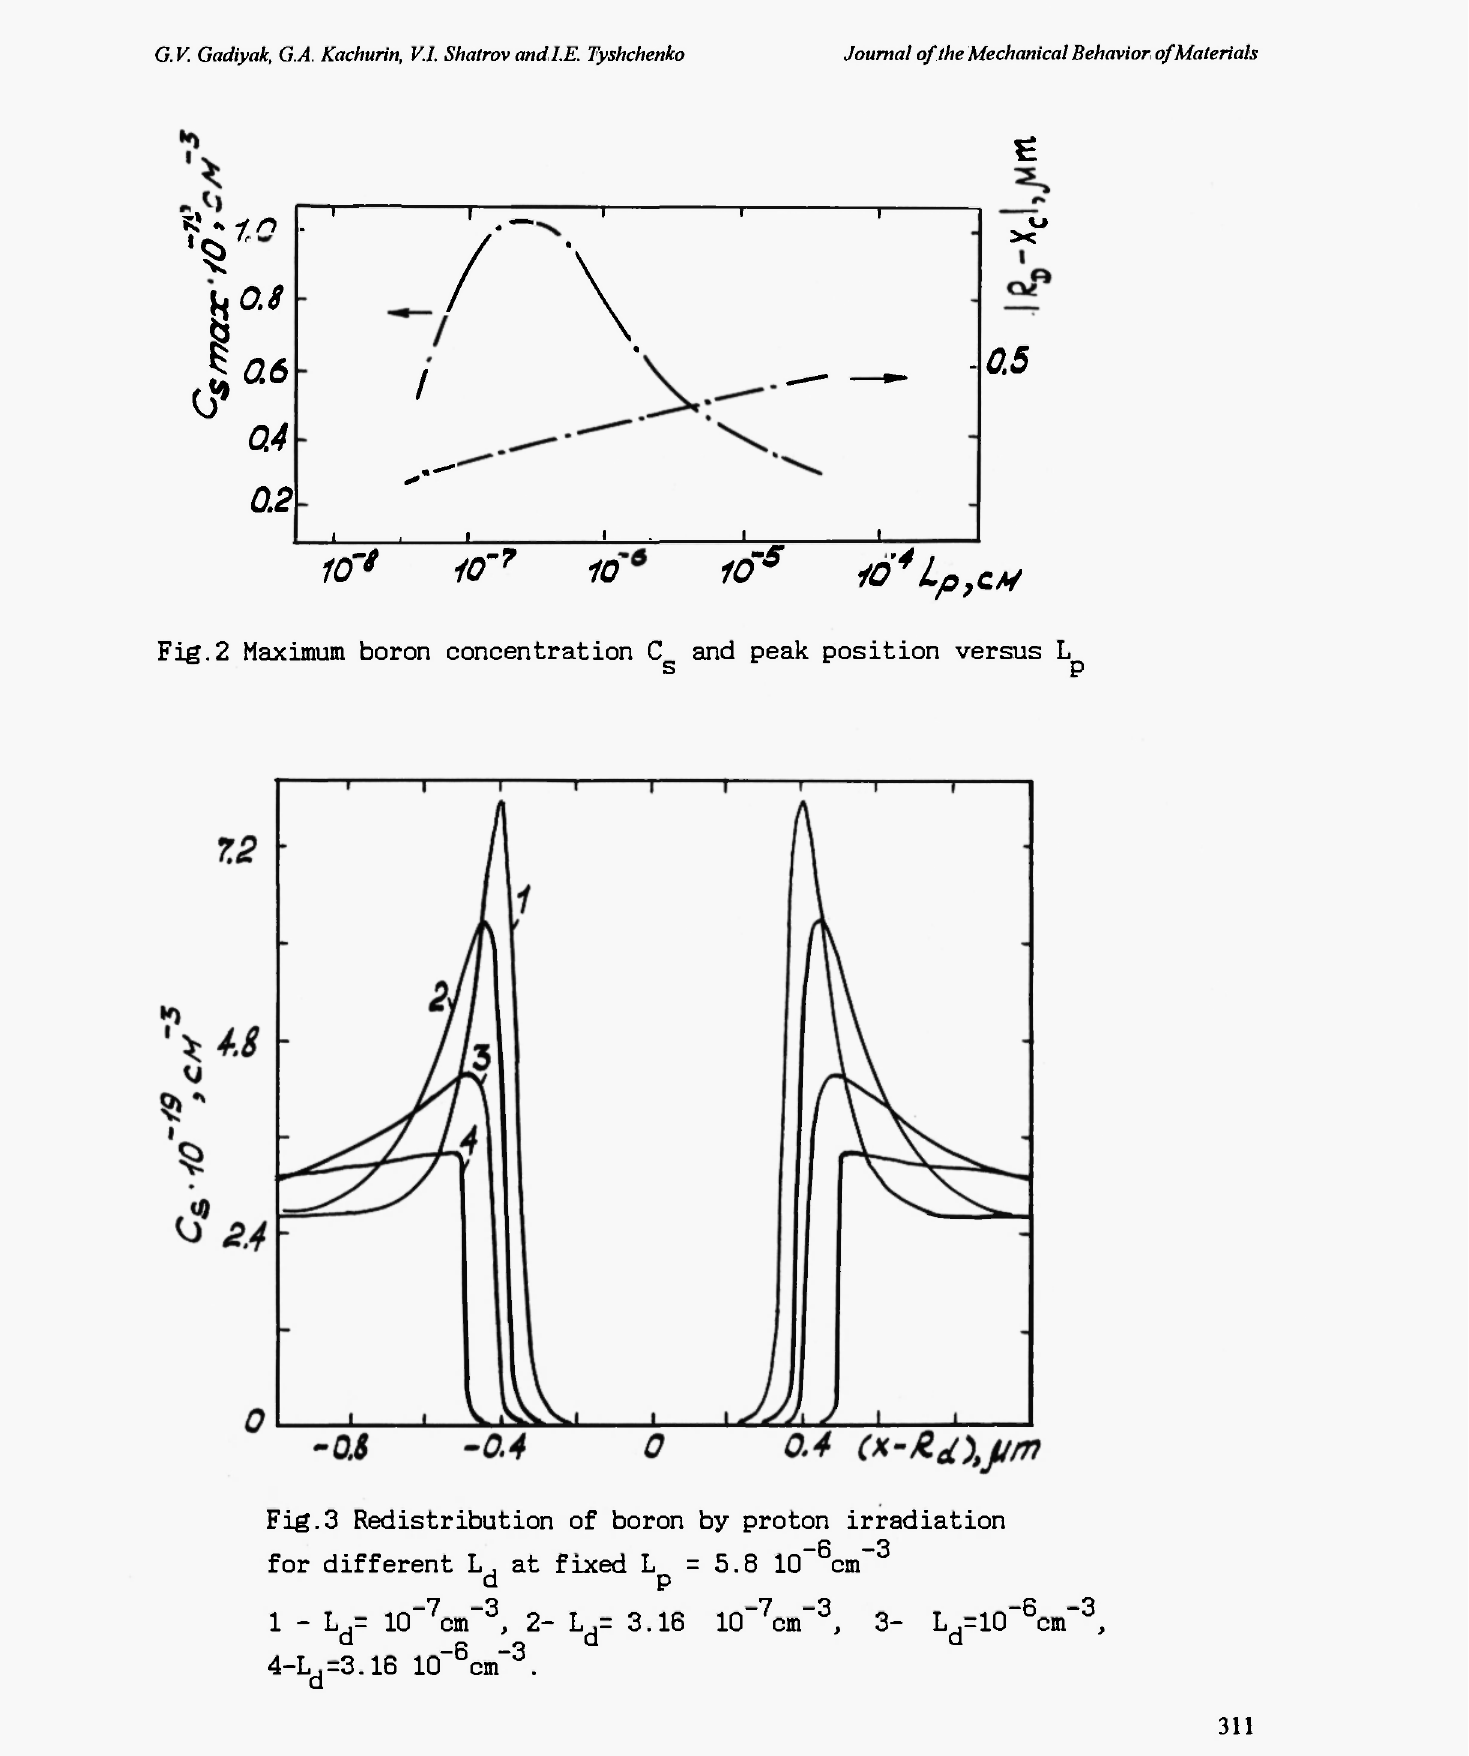
Fig.3 Redistribution of boron by proton irradiation —6 —3 for different L , at fixed L = 5.8 10 cm d Ρ 1 - L d = 10" 7 cm" 3 , 2- L d =